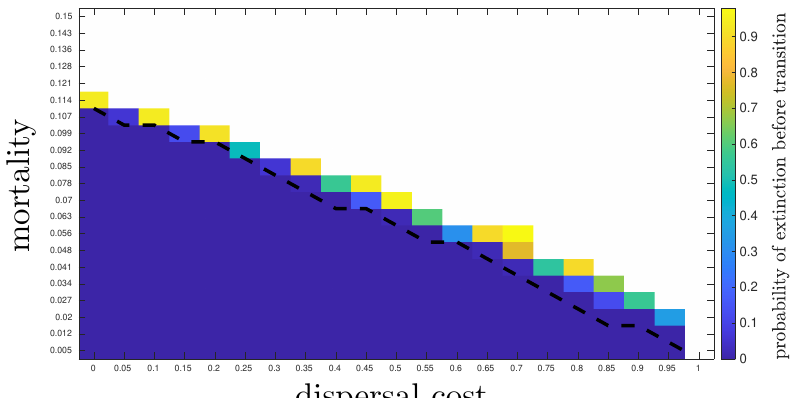
Figure SI.13. Frequency at which evolutionary rescue occurs. This figure is identical to Figure 6, except that it maps the probability of extinction before the transition, instead of the mean percentage of mutualistic symbionts. The dotted black line indicates the upper boundary of viability for the parasitic system, without evolution. Above the dotted black line, in some cases the evolution of mutualism rescued the whole system, although the parasitic system is unviable alone. In the white region, the systems goes extinct, even with